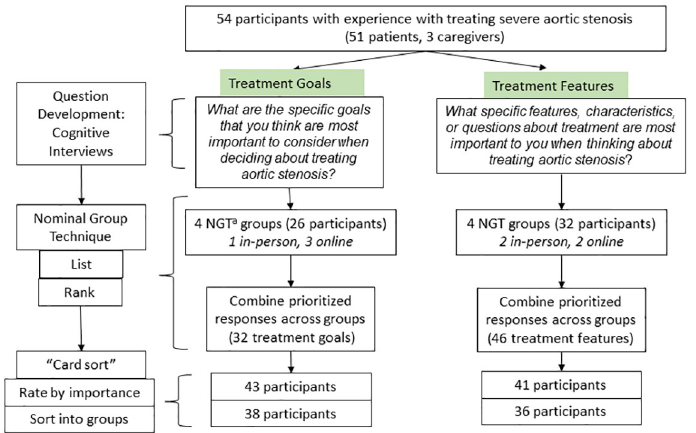
the study. a NGT: Nominal Group